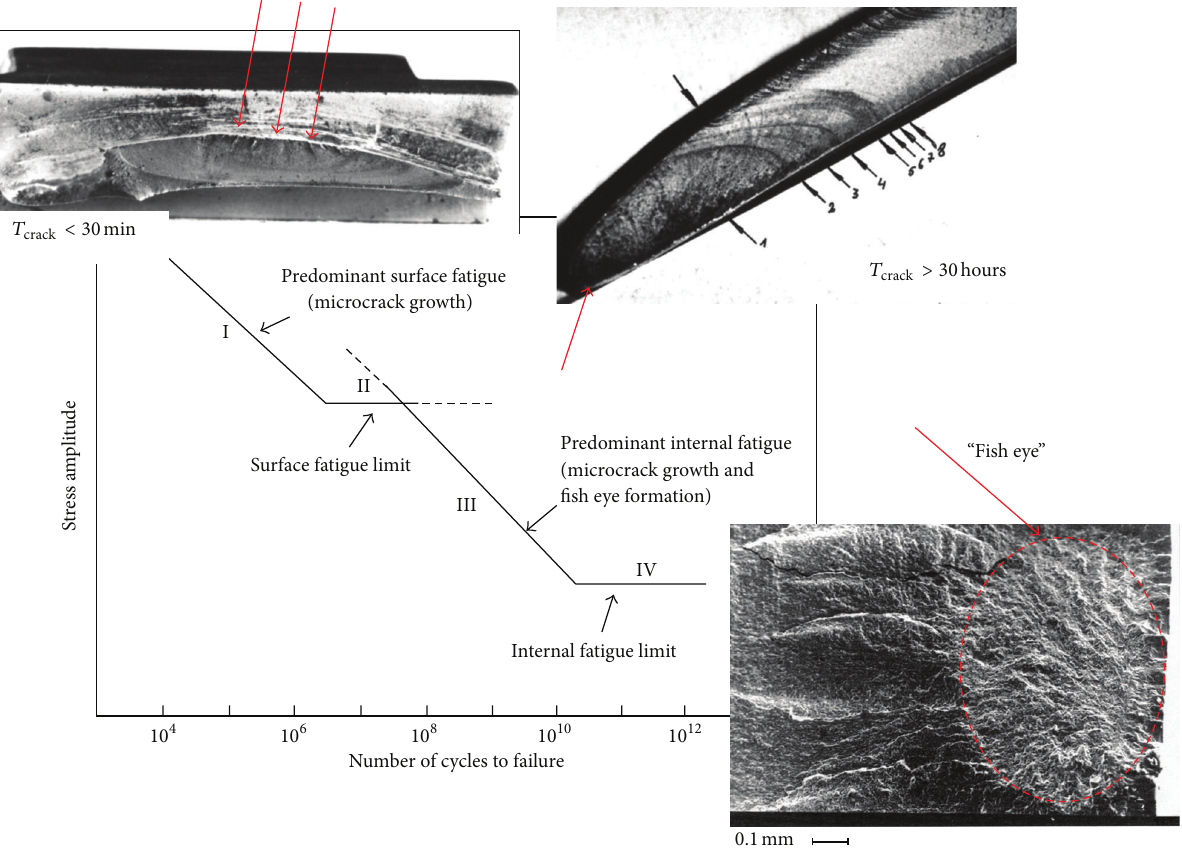
Figure 4: Fatigue problems (LCF, HCF, and VHCF) of compressor blades [3,